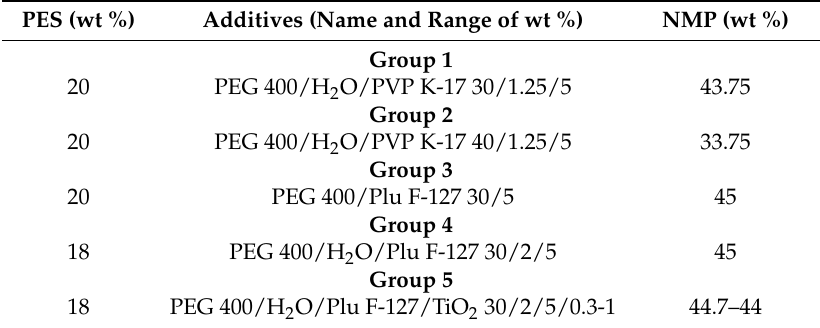
Table 3. Composition of polymeric dopes used in the spinning experiments.